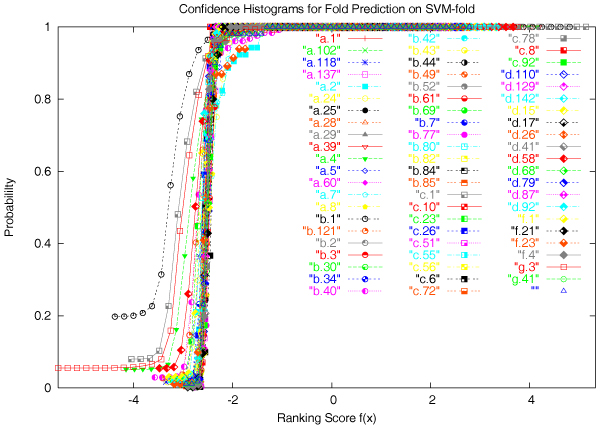
SVM-Fold fold detection confidence. Confidence vs. ranking score for fold detection on the SVM-Fold server.